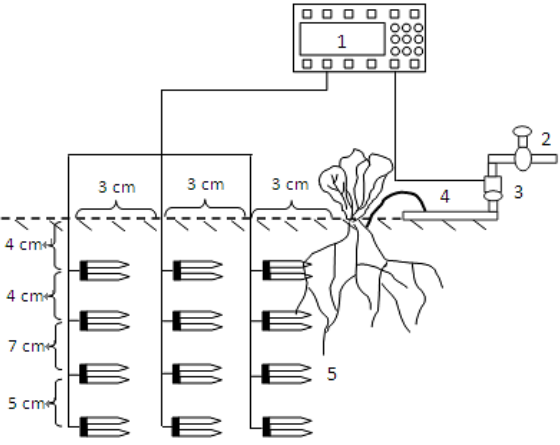
Figure 1. Schematic diagram of the experiment; (1) Programmable controller; (2) Pressure-regulated water source; (3) Solenoid valve; (4) Drip emitter; (5) EC-5 sensors.